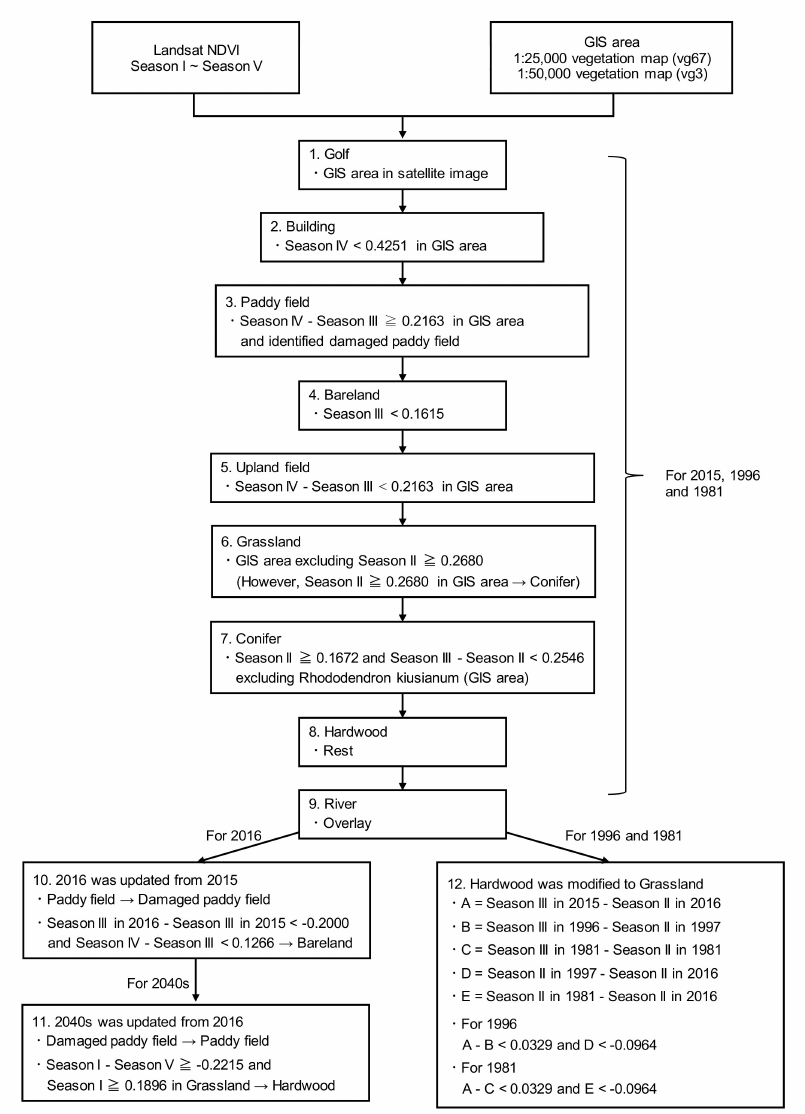
Figure 2. Flowchart of land cover